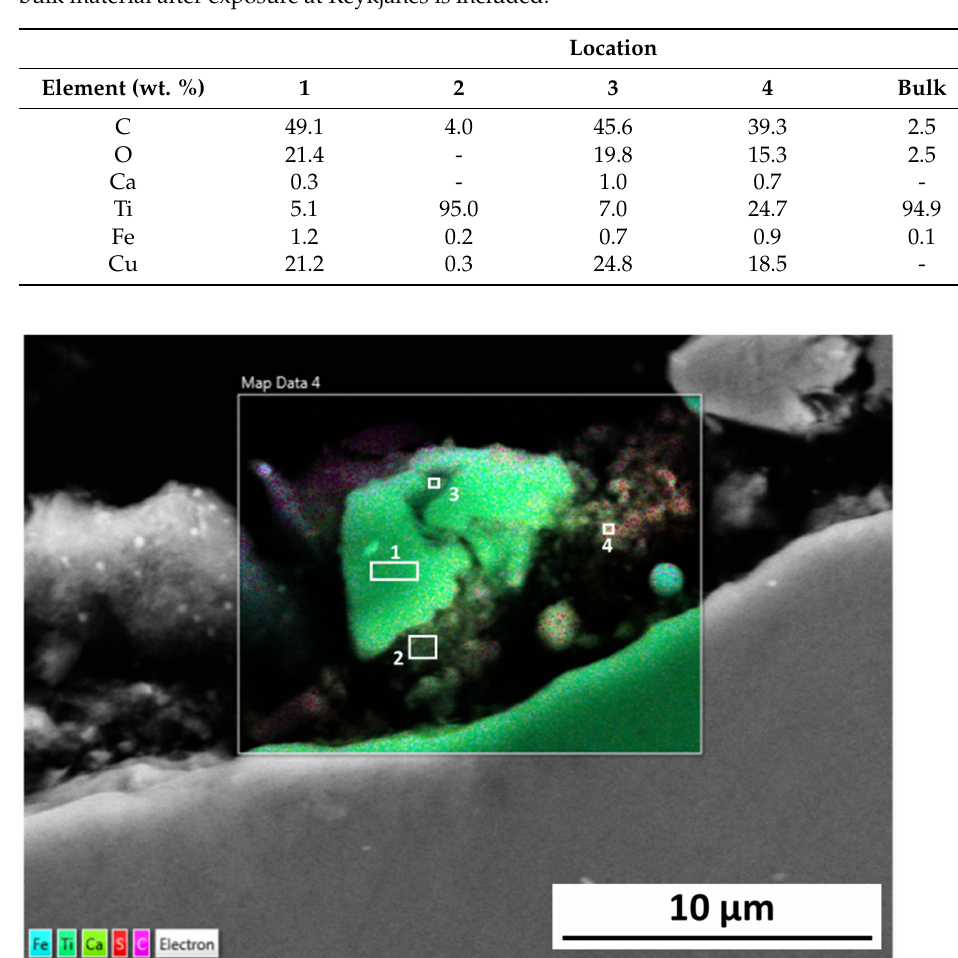
Table 12. EDX elemental analysis of locations shown in Figure 18. For comparison, an analysis of the bulk material after exposure at Reykjanes is included.